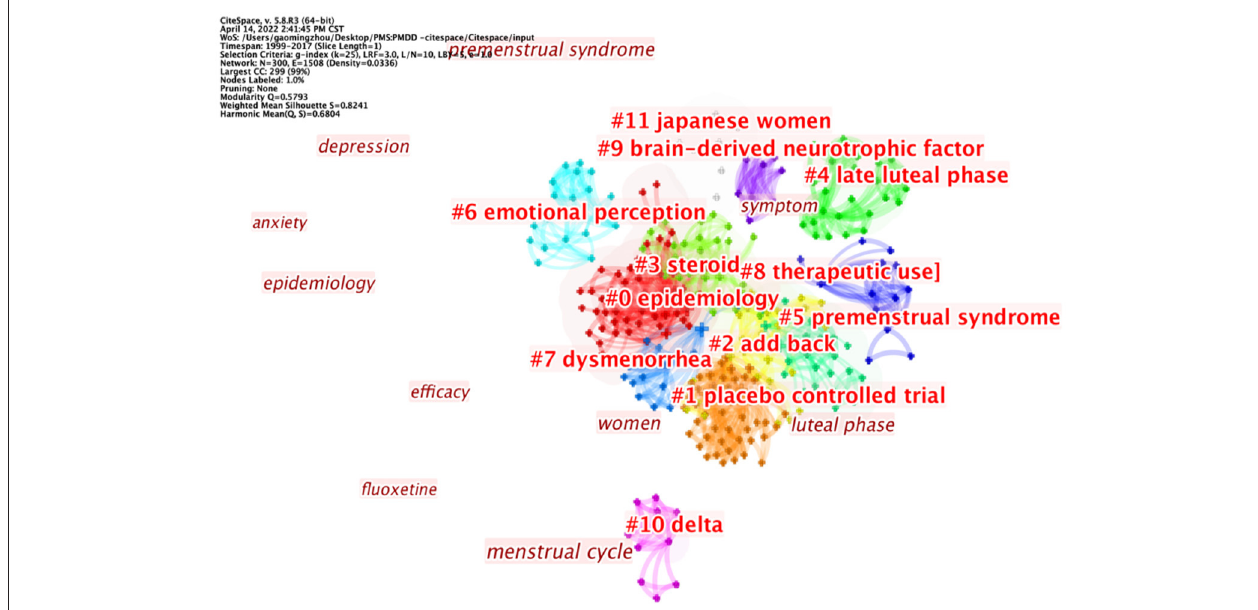
FIGURE 7 | Network showing interaction among cooccurring keywords in the top 100 cited papers.